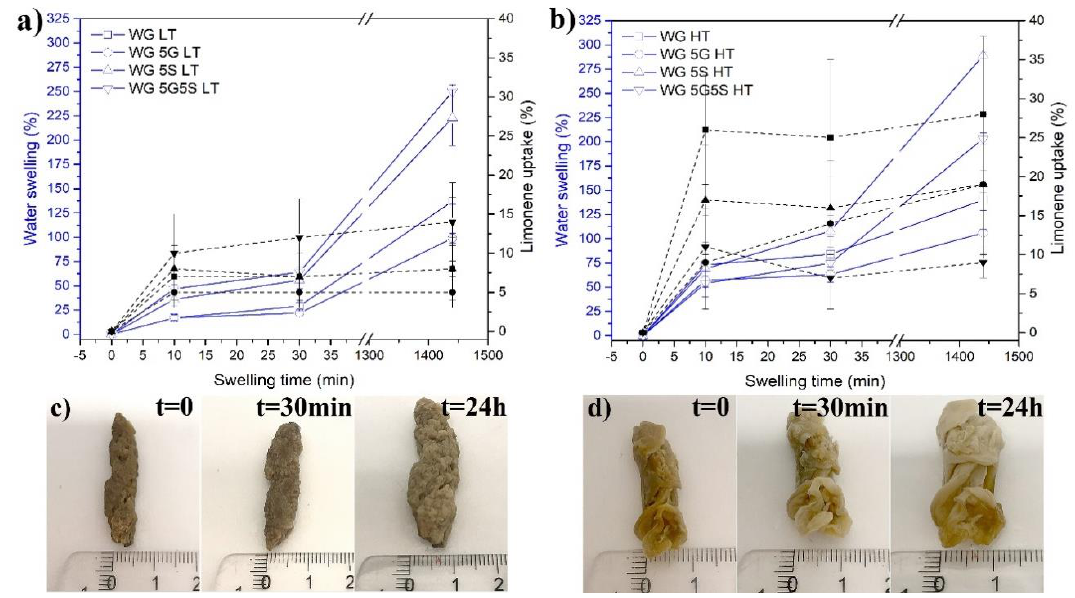
Figure 2. Liquid uptake in the different samples at low ( a ) and high ( b ) extrusion temperatures. A representative specimen of WG 5G5S LT ( c ) and WG 5S HT ( d ) after a 24 h swelling in water are shown. The continuous line with hollow symbols corresponds to water swelling, and the dashed lines with filled symbols correspond to limonene uptake.